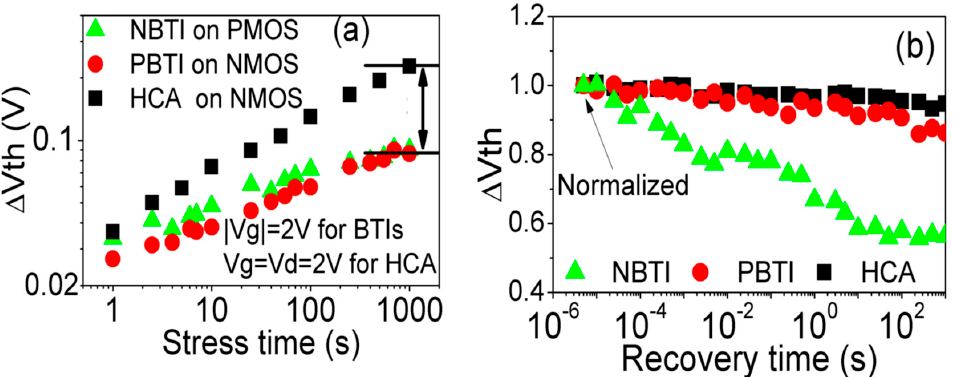
Figure 41. A comparison of PBTI with NBTI during stress ( a ) and recovery ( b ). ( a ) Shows that the